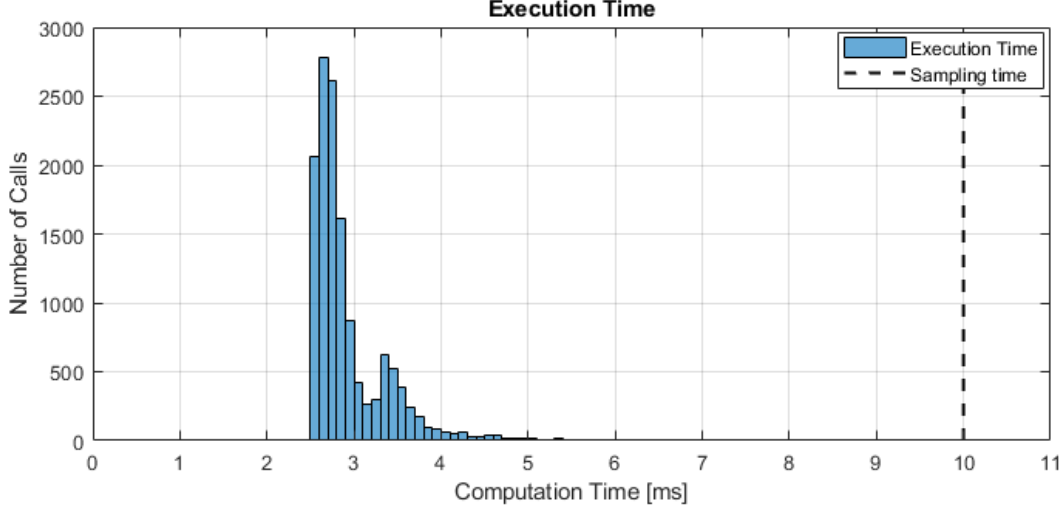
Figure 8. The execution time required by ACADO to solve the